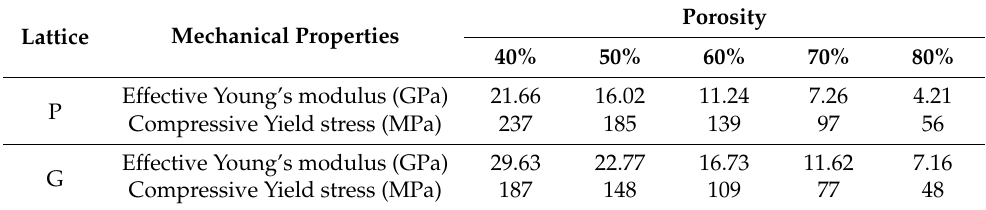
Table 1. Effective Young’s modulus and compressive strength obtained from the compressive loading on P and G lattice structures with varying porosities.